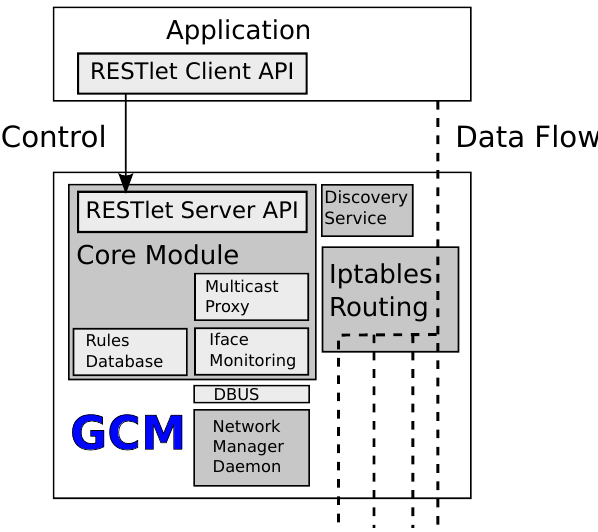
Figure 2: GRCBox Architecture with GCM modules in